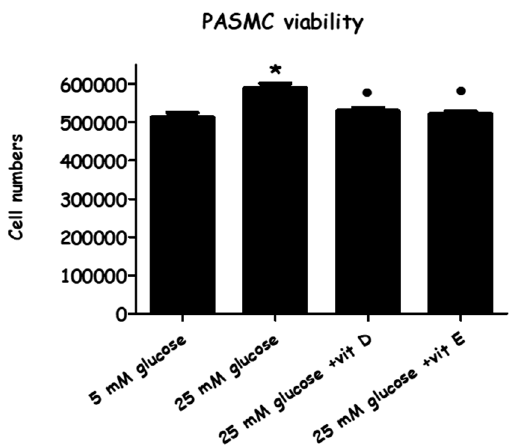
Figure 3. The effect of vitamin D/vitamin E in high glucose-induced pulmonary artery smooth muscle cells (PASMC) proliferation. Cells were cultured with normal glucose (five mM) and high glucose (25 mM) for 72 h. Vitamin D (80 ng/mL) and Vitamin E (9 µg/mL) were added immediately along with the high-glucose incubation. Cells were stained with trypan blue dye, and the viable cells were counted after 72 h. Each value represents the mean ± SEM from four independent experiments. * p < 0.05 vs. cells cultured in normal glucose (five mM) media. • p < 0.05 vs. high glucose stimulated cells. ANOVA one way followed by Tukey’s comparison test was performed.